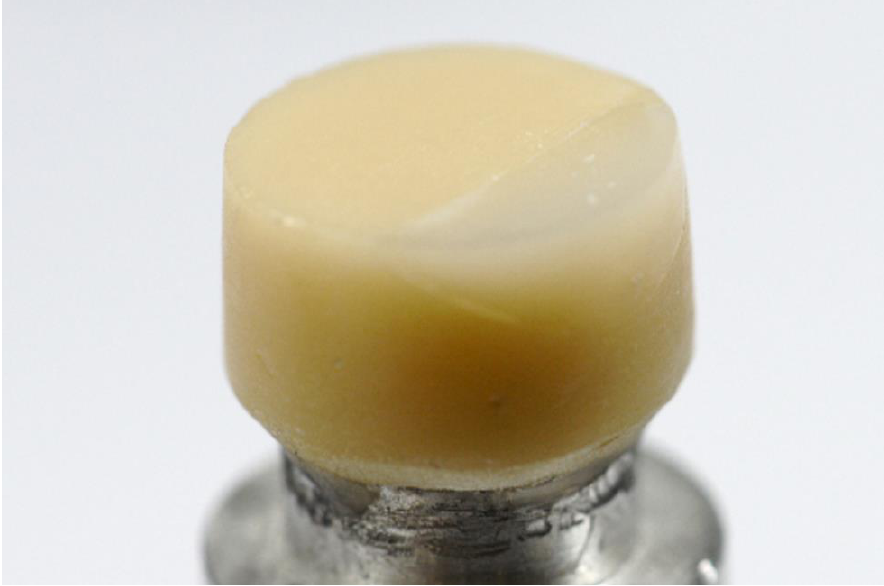
Figure 4. Repaired specimen with bonded